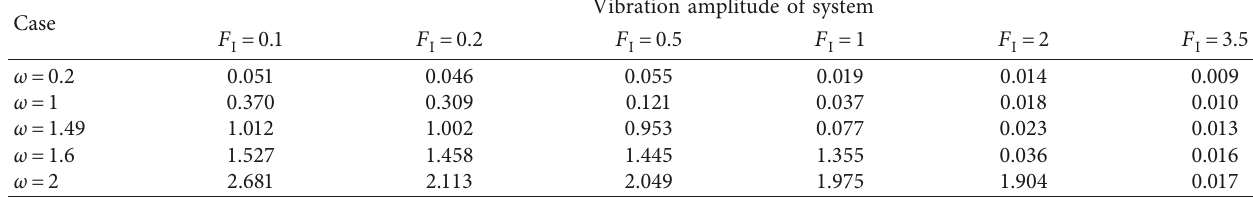
Table 1: Comparison of amplitude corresponding to F